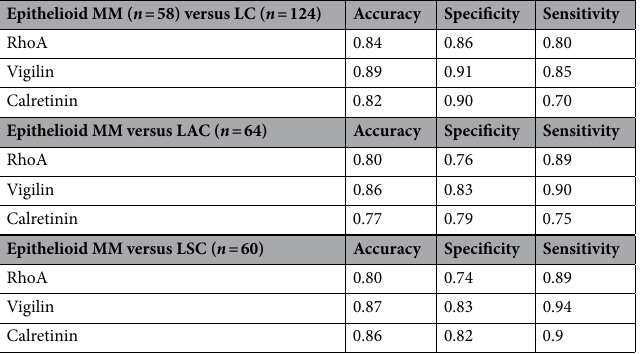
Epithelioid MM versus LSC ( n =